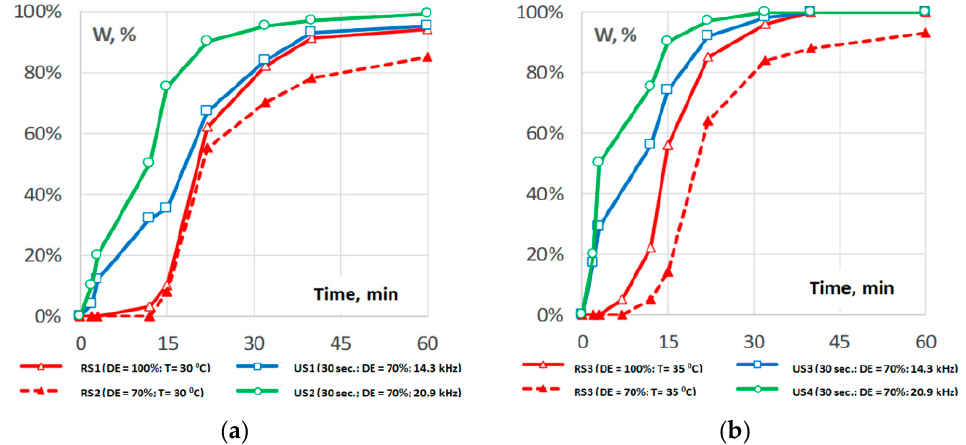
Figure 8. Kinetics of water fallout at depending on the spectrum of ultrasound exposure: ( a ) W/OE temperature of 30 ° С , W/O = 67%, and US1- 14.3 kHz, US2- 20.9 kHz ; ( b ) W/OE temperature of 35 ° С , W/O = 67%, , and US3- 14.3 kHz, US4- 20.9 kHz. As can be seen from the results of the research (Figure 8), even at low values of temperature (30 ° С ) and a smaller volume of used demulsifier, it was possible to achieve 100% of water separation at a fundamental frequency of 20.9 kHz.